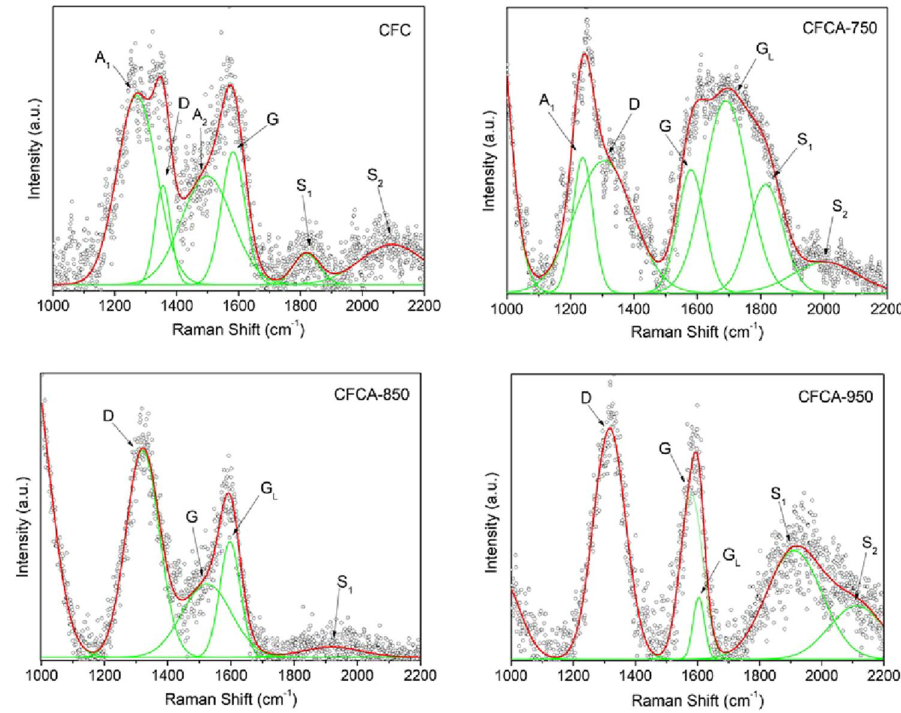
Fig. 2 Raman spectra of keratin and